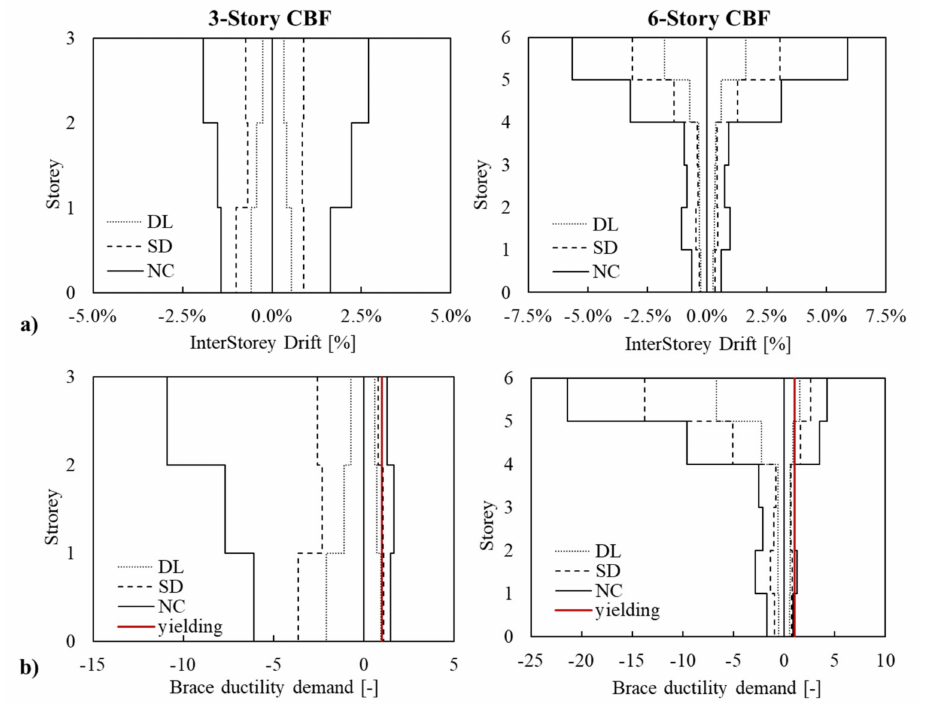
Figure 8. Results from IDAs for examined CBFs: ( a ) Interstorey drift ratio; ( b ) braces ductility demand.